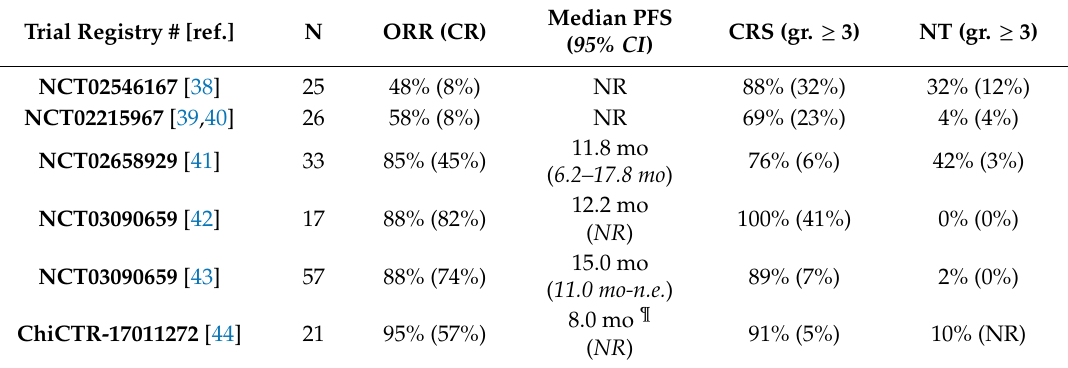
Table 3. E ffi cacy and toxicity data of selected § B-cell maturation antigen (BCMA)-targeted CAR-T-cell therapies in multiple myeloma